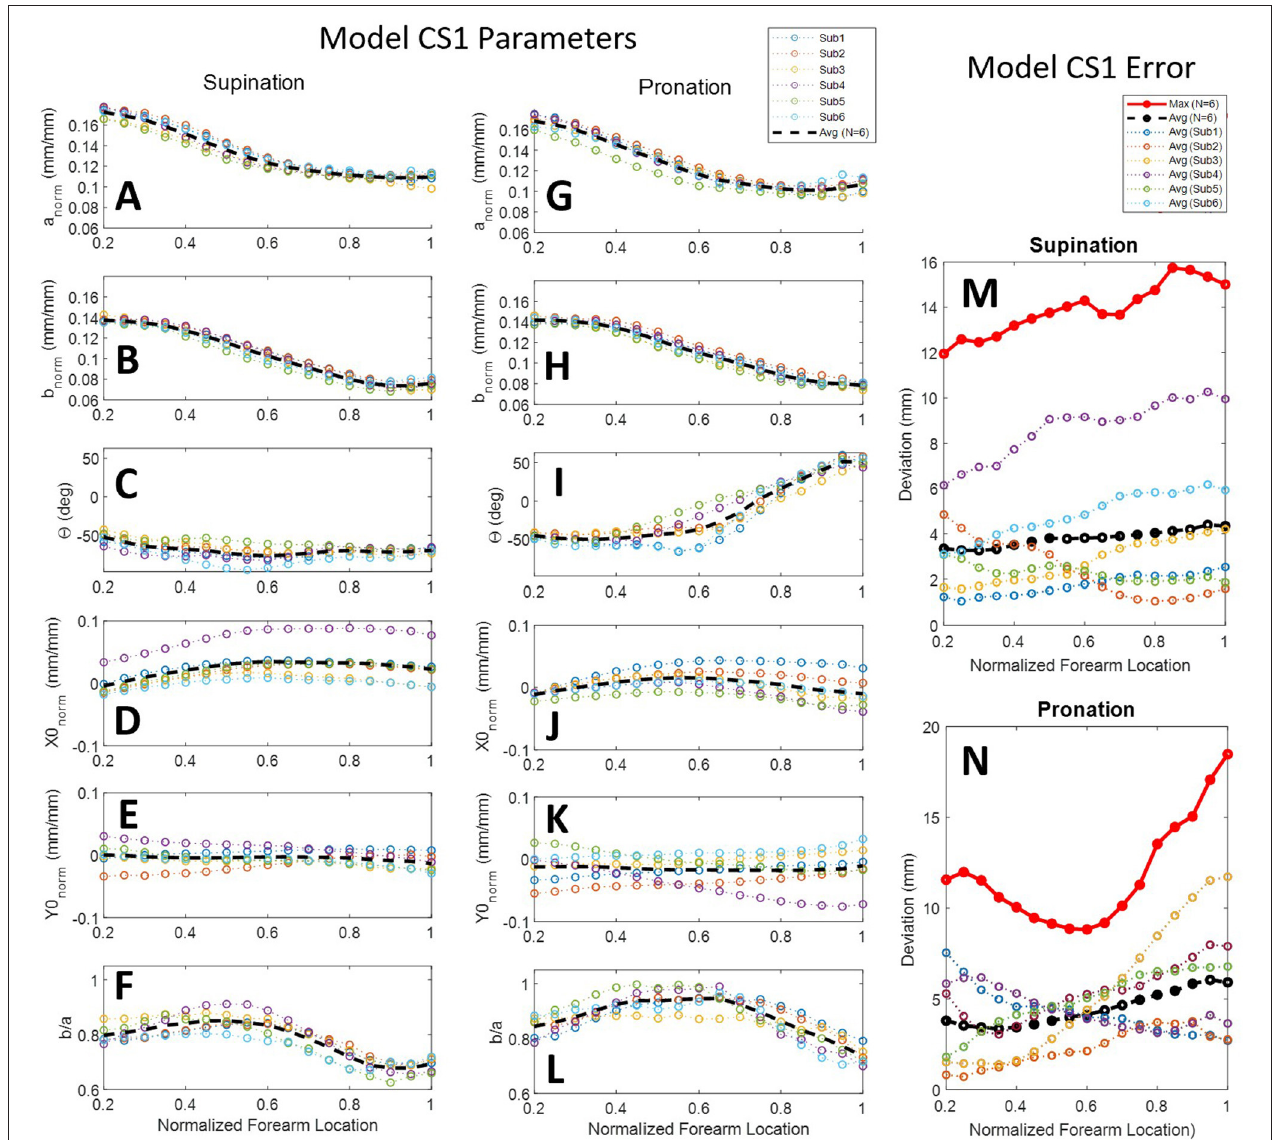
FIGURE 8 | Ellipse-fit model parameters and model error for the combined subjects model CS1: Model parameters for individual subjects, their averages, and their 3rd-order polynomial fit for supination (A–F) and pronation (G–L) scans; Resulting modeling errors of comparing 3D models generated by the 3rd-order polynomials to the original subject scans are shown in supination (M) and pronation (N) . Legend for panels (A–L) shown above panel (G) . Legend for panels (M,N) shown above panel (M)